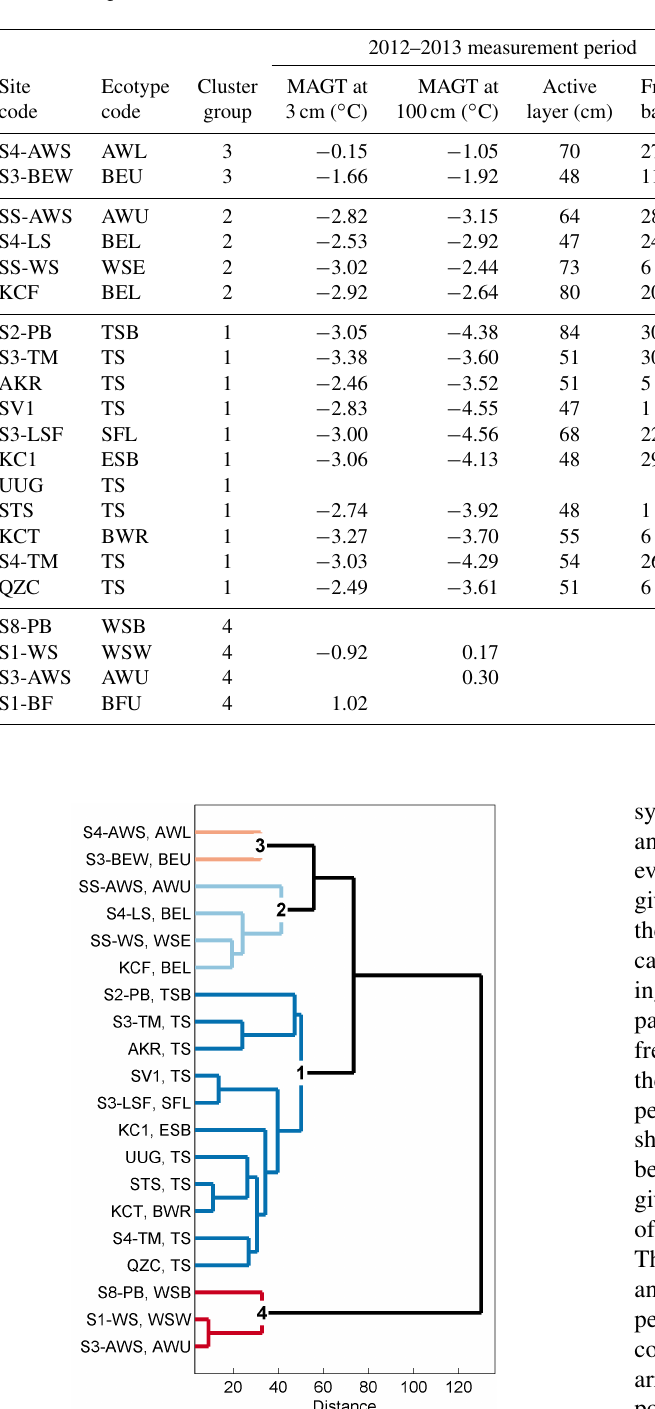
Table 3. A summary of the MAGT at 3 and 100cm, the active layer depth, and the freeze-back date, for all study sites and for our two main measurement periods.